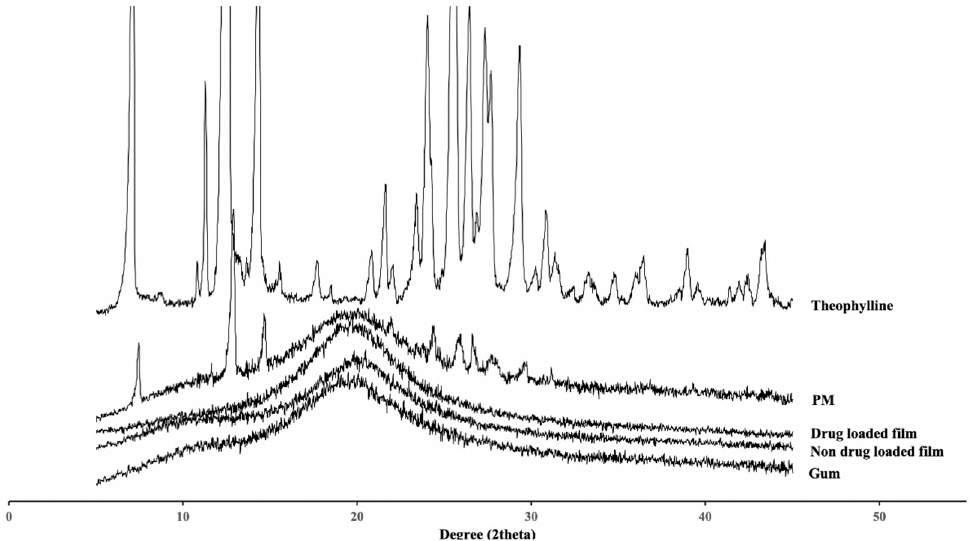
Figure 4. Powder XRD patterns of gum, theophylline, their physical mixture (PM), and the drug- loaded/non-drug-loaded films.